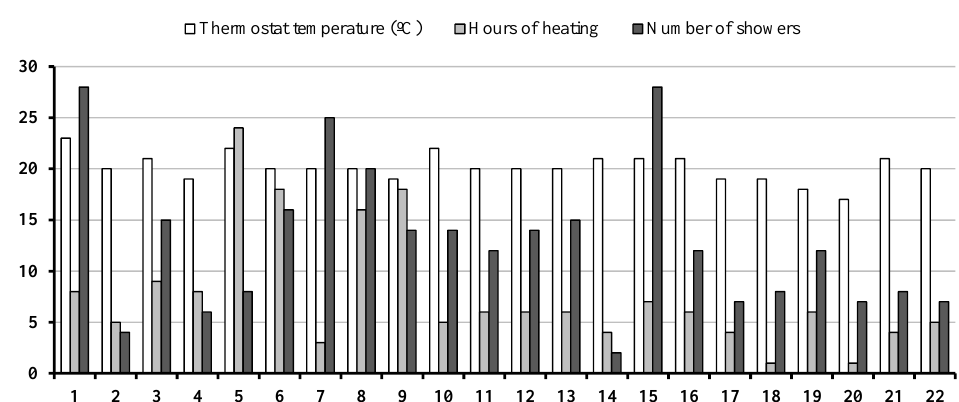
Fig. 1. Questionnaire responses for the three main user behaviour parameters influencing energy consumption. Regarding the heating thermostats temperature, the values vary between 17 ºC and 23